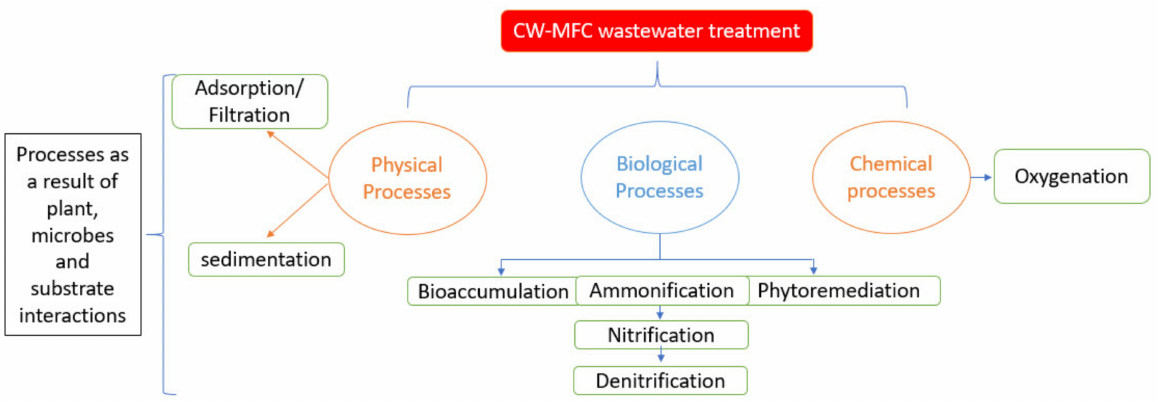
Figure 5. Interacting processes involved in contaminant